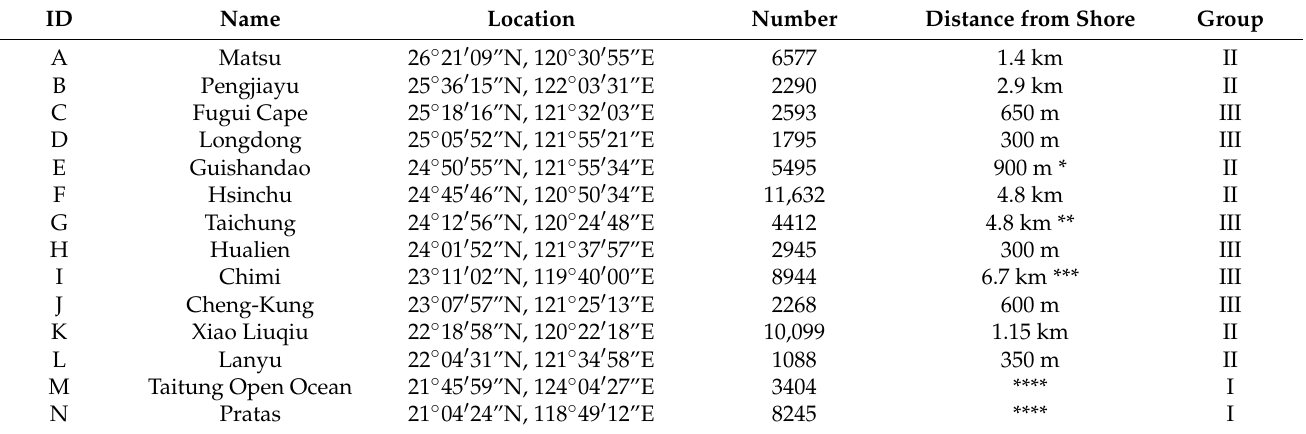
Table 2. The ID, name, location, number of bulk-skin SST data pairs, distance from shore, and classification of 14 buoys from the CWB. Buoy stations are classified into Group I (open sea area), Group II (nearshore, bay, and island), and Group III (coastal area, estuary, and water